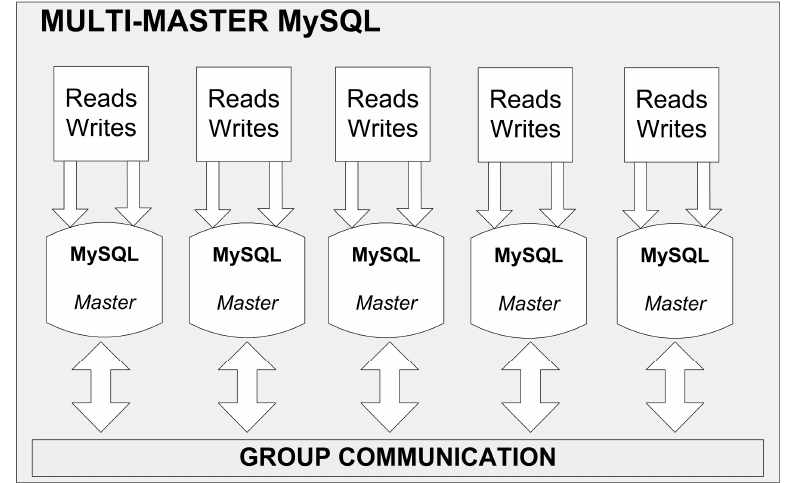
Figure 7. The operation of Galera replication.